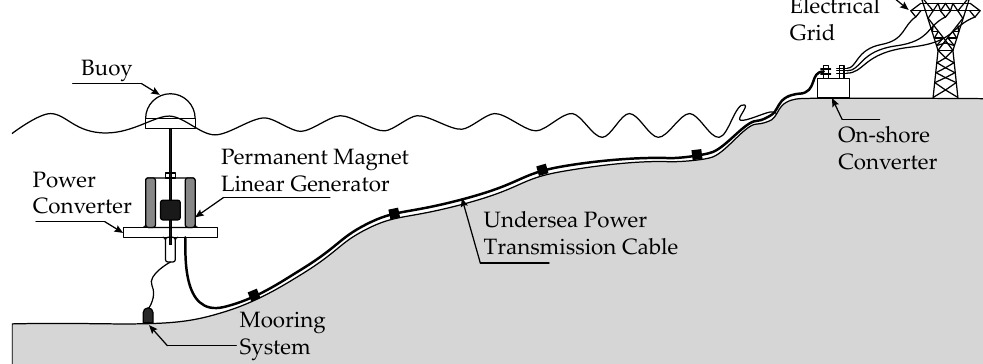
Figure 2. Wave energy converter